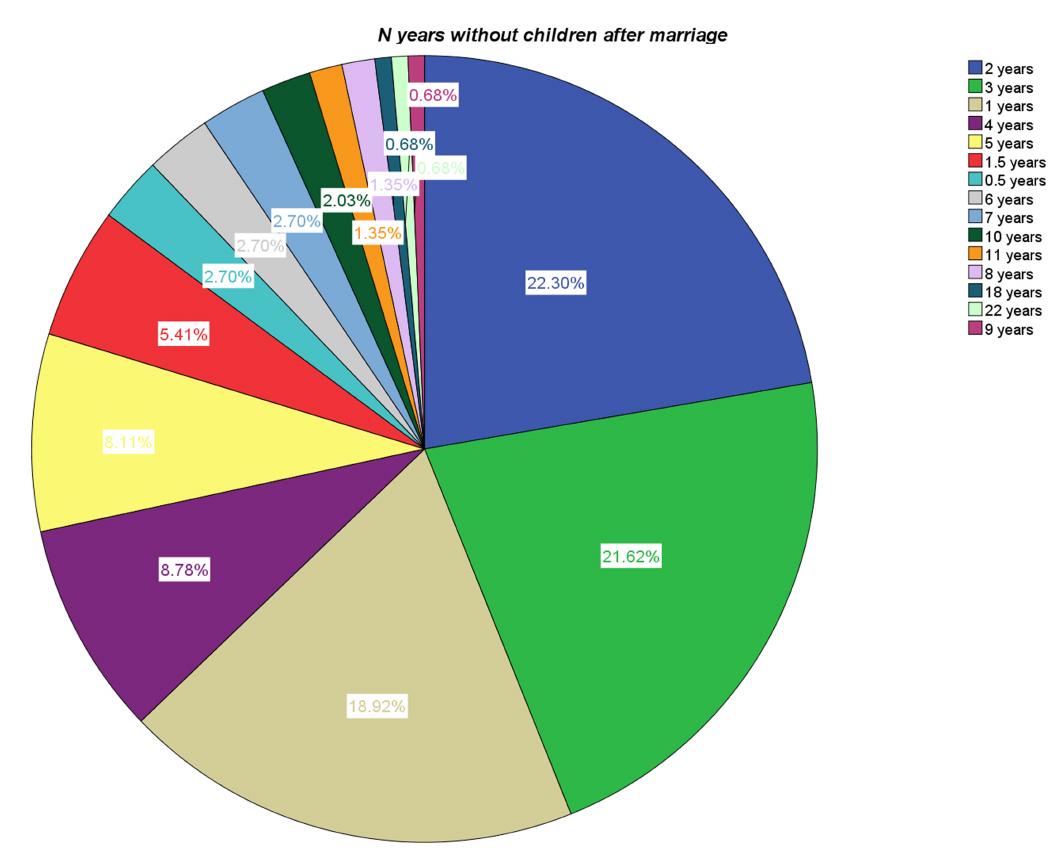
Fig. 1. The distribution duration of infertility after marriage.